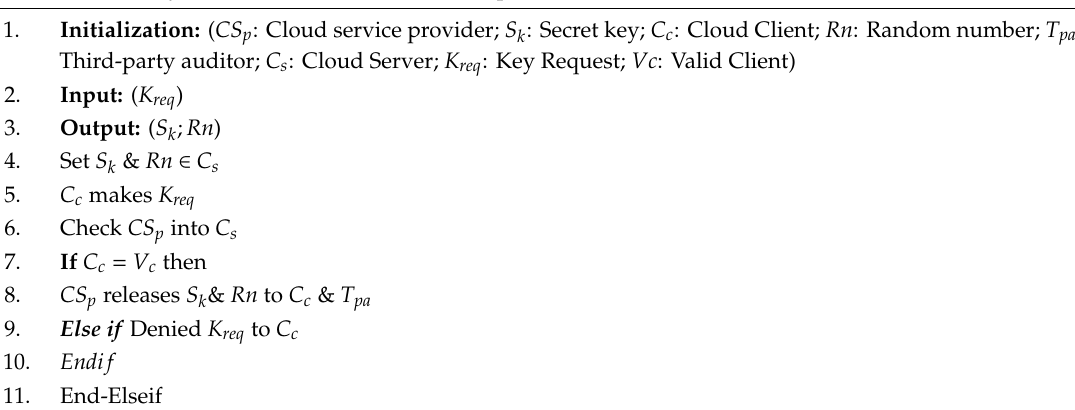
Algorithm 1. Key-Generation and authentication